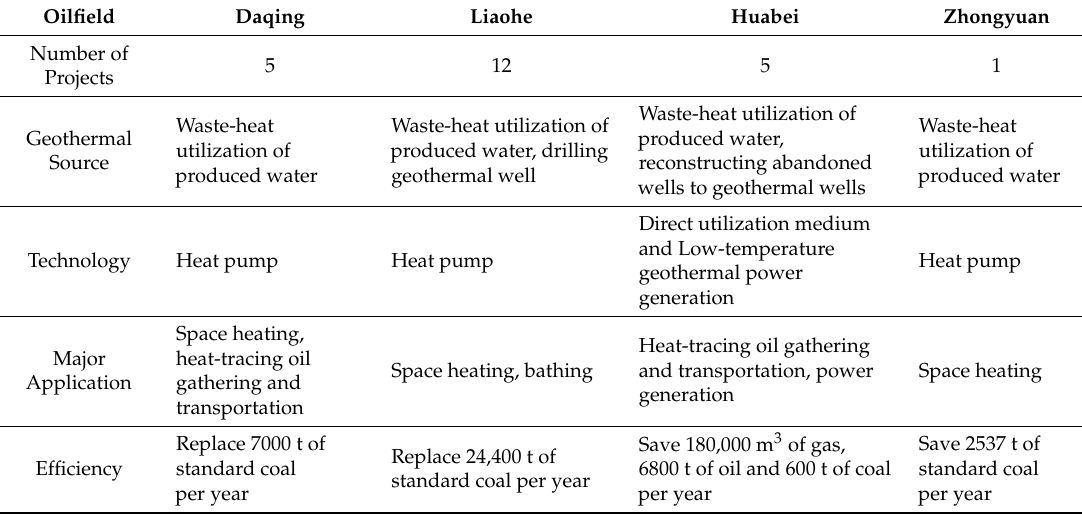
Table 1. Geothermal energy utilization projects in